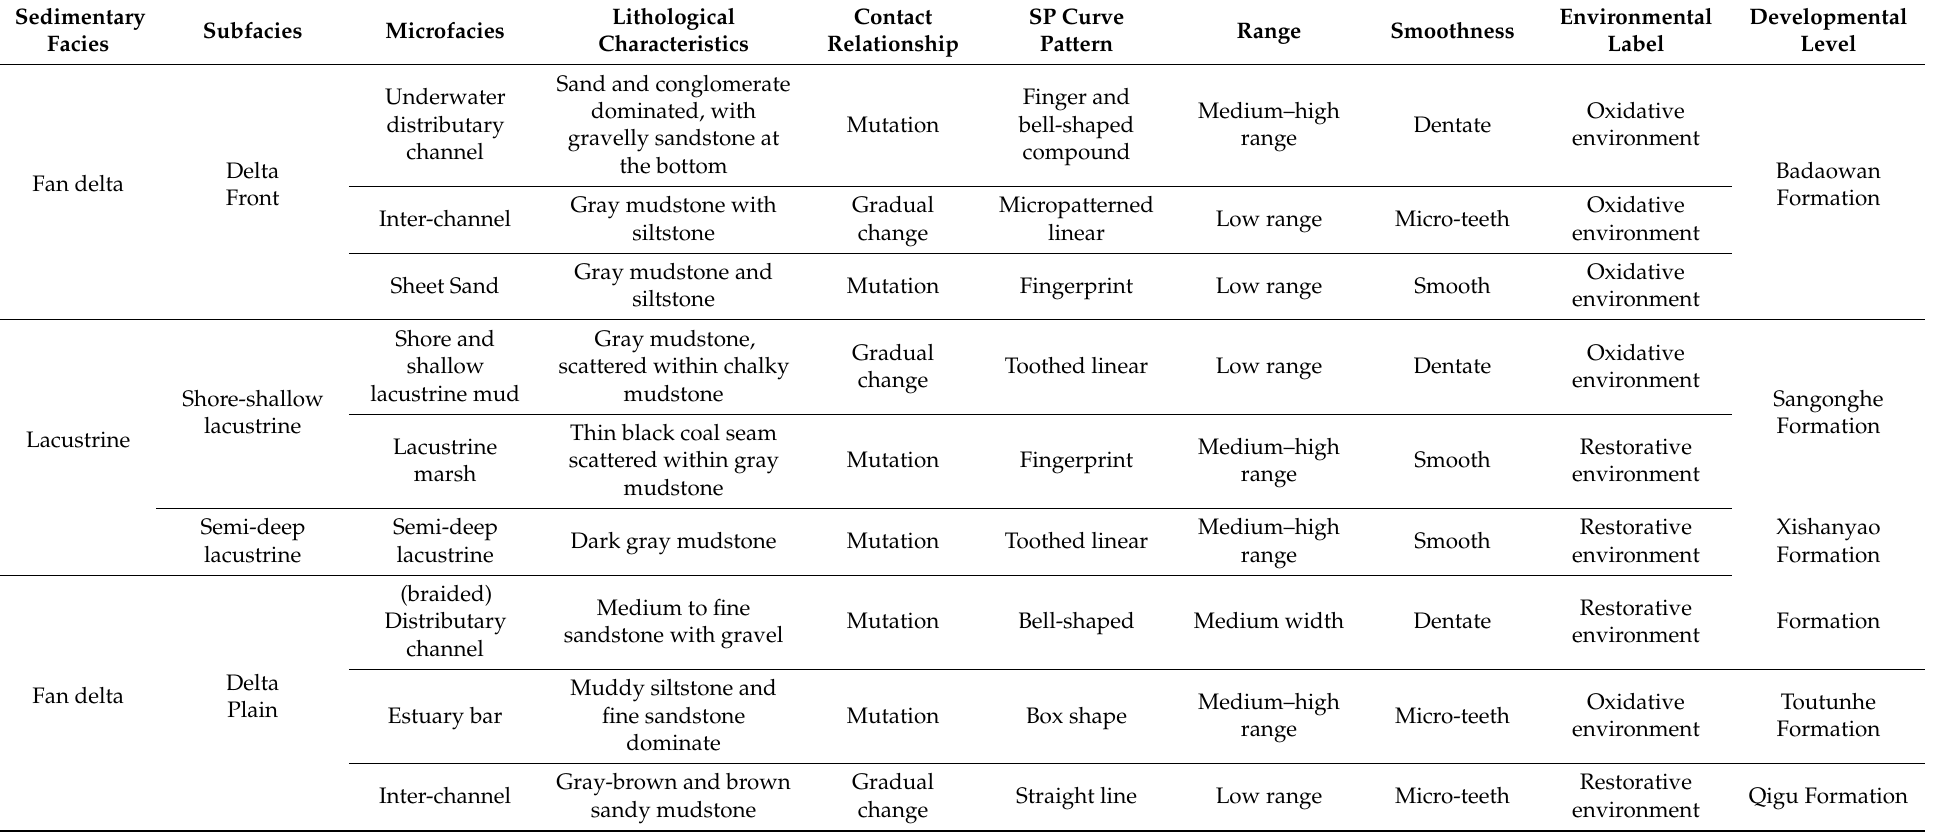
Table 2. Logging facies